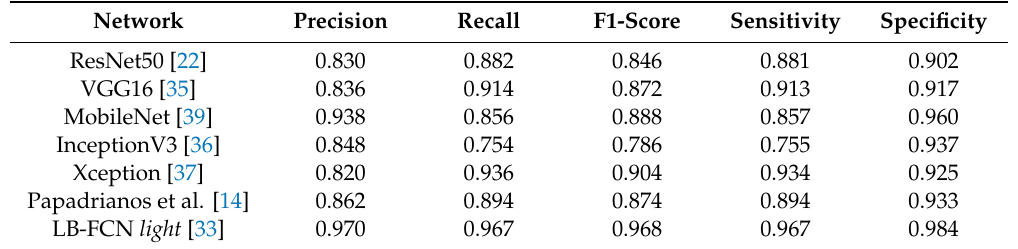
Table 4. Comparative classification performance for the degenerative class.